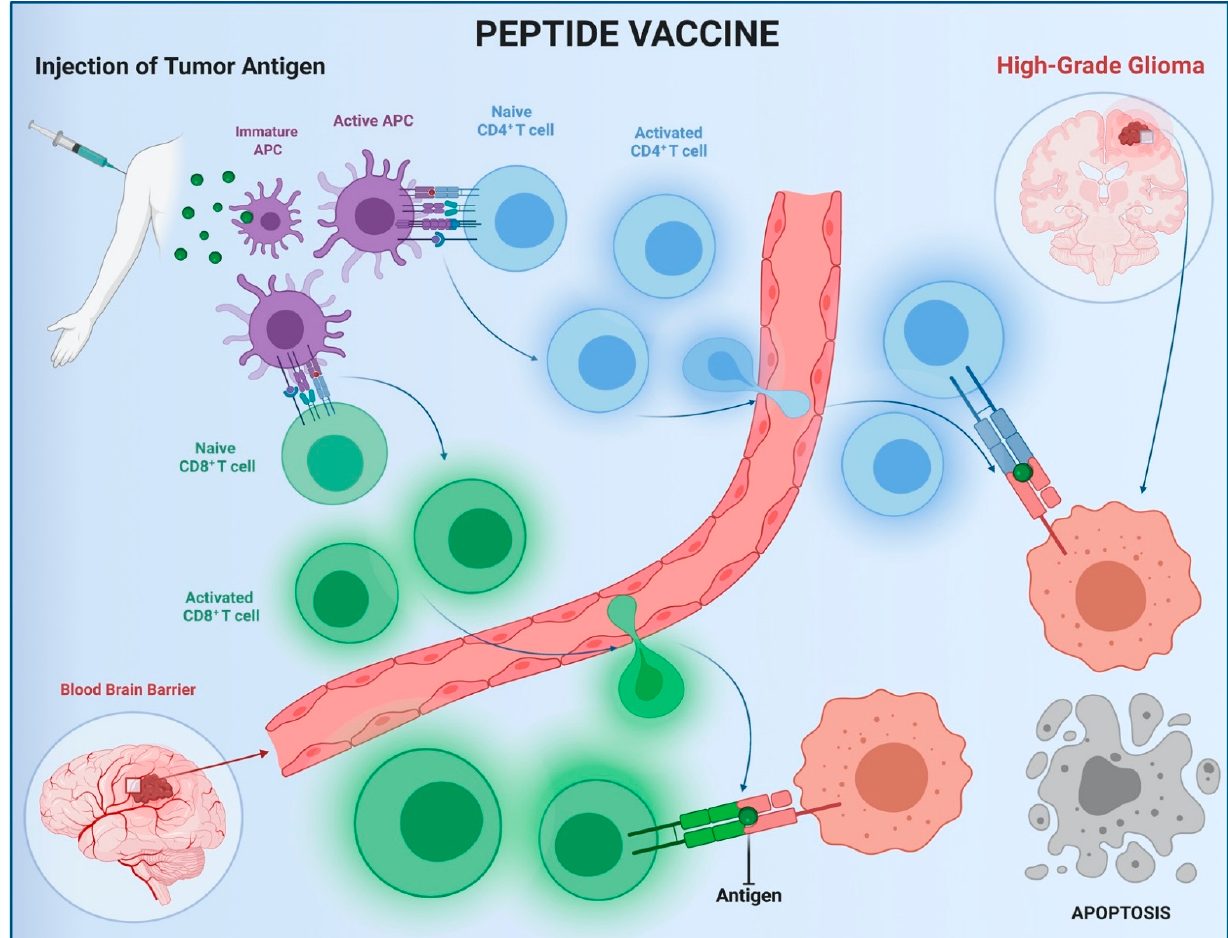
Figure 4. Peptide vaccine mechanism of action. APC: Antigen-Presenting Cell.